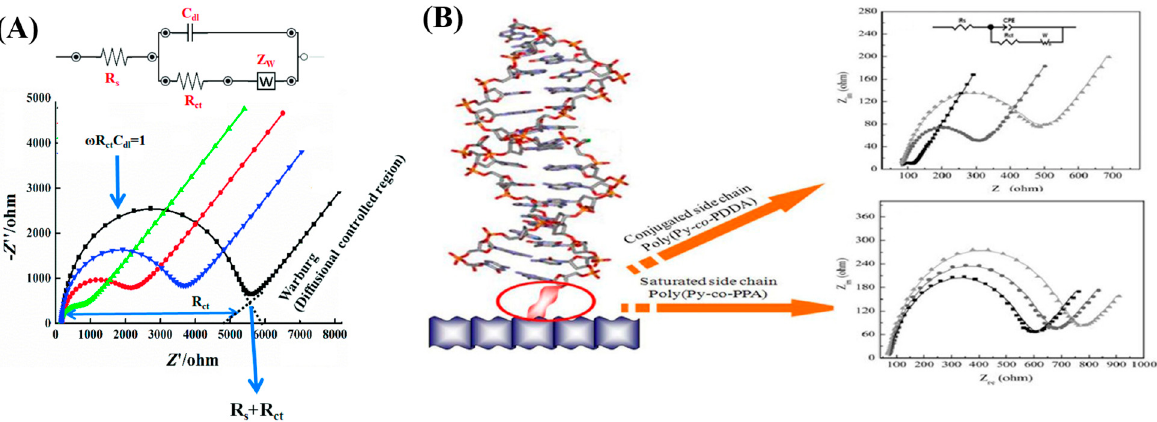
Figure 1. ( A ) Equivalent circuit of the EIS. Reproduced with permission from Ref. [14] and ( B ) Nyquist plots for electrochemical impedance measurements for poly(Py-co-PPDA) with and without immobi- lization of probe DNA. Reproduced with permission from Ref.